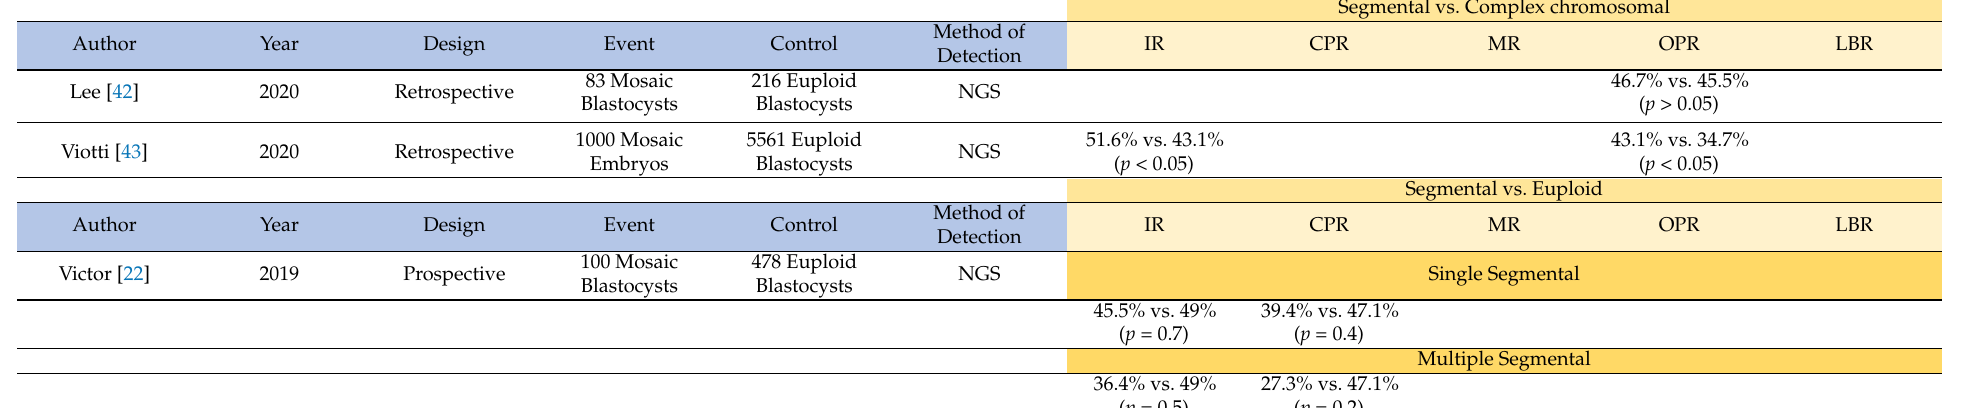
Segmental vs. Complex